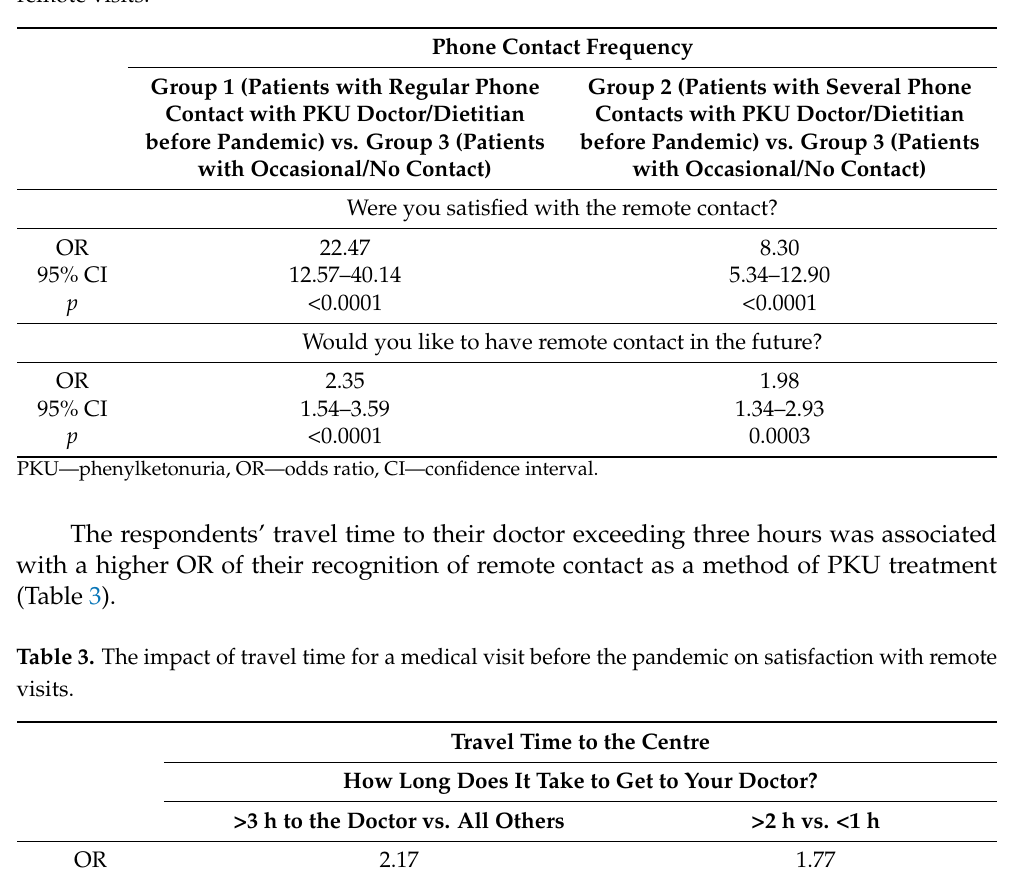
Table 2. The impact of contact frequency with a doctor before the pandemic on satisfaction with remote visits.